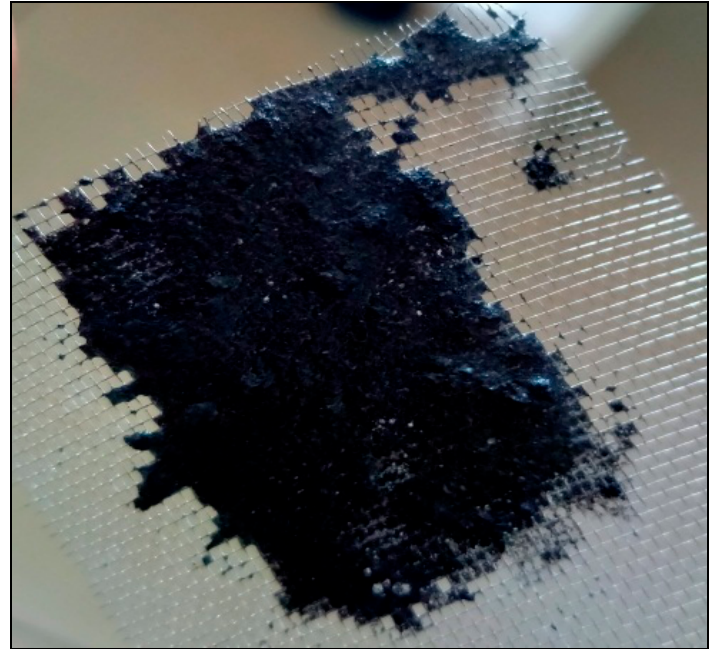
Figure 2. Stainless-steel wire mesh anode.